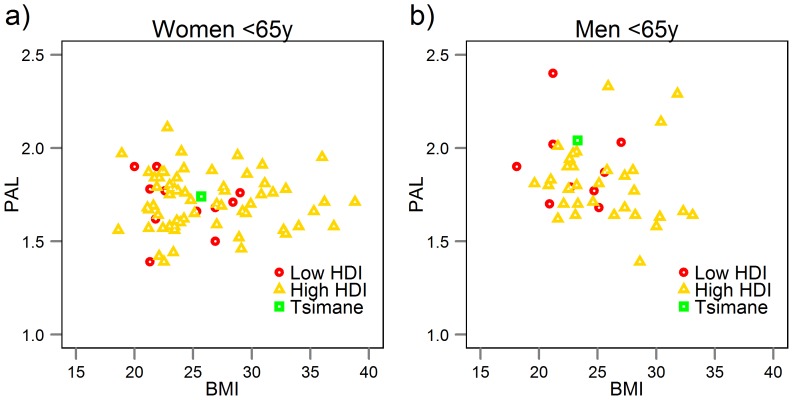
Physical activity levels (PALs) from a compendium of populations, shown separately for developing (low or middle Human Development Index (HDI) populations) and developed societies (high HDI) [40].Tsimane are represented as the green triangle. Mean PAL for developing societies is 1.88 (men) and 1.70 (women), for developed societies is 1.79 (men) and 1.71 (women).